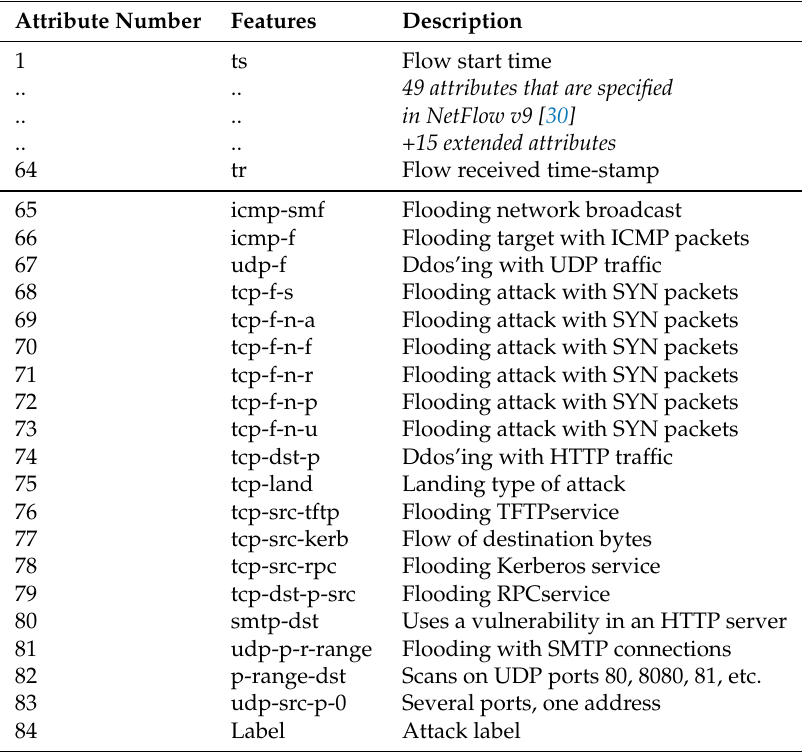
Table 7. LITNET-2020 dataset features’ list with